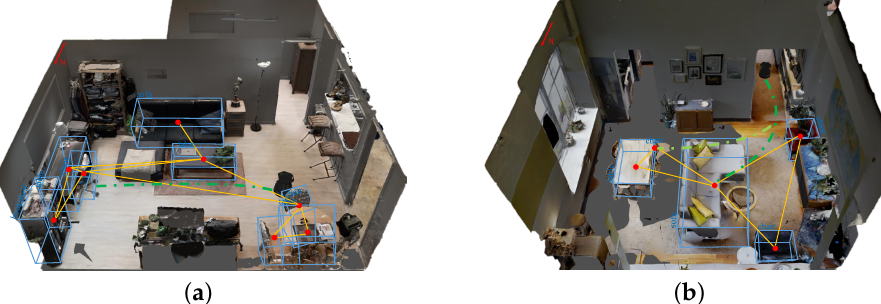
Figure 1. Illustration of the proposed object-level topological path planning for visual navigation. ( a , b ) shows two different indoor scenarios. The blue boxes represent the 3D object detection of object-level landmarks. The red dots indicate the nodes of the topological map. The yellow lines indicate the edges of the topological map. The green curve is the feasible navigation trajectory generated based on the proposed